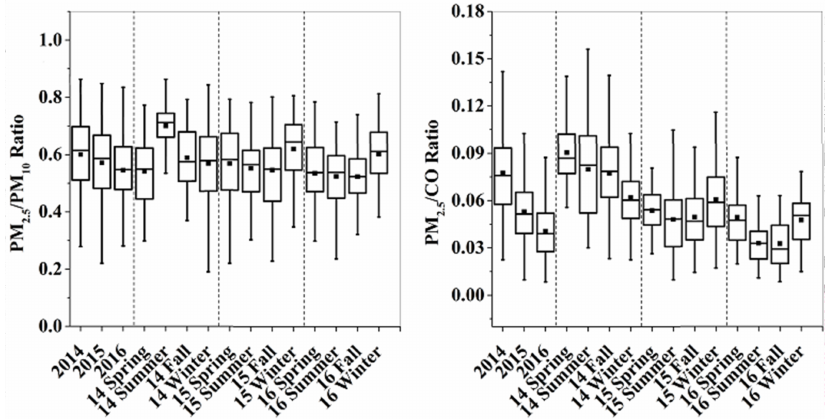
Figure 2. The statistical boxes for the ratios of PM 2.5 /PM 10 and PM 2.5 /CO across different seasons in 3 years.